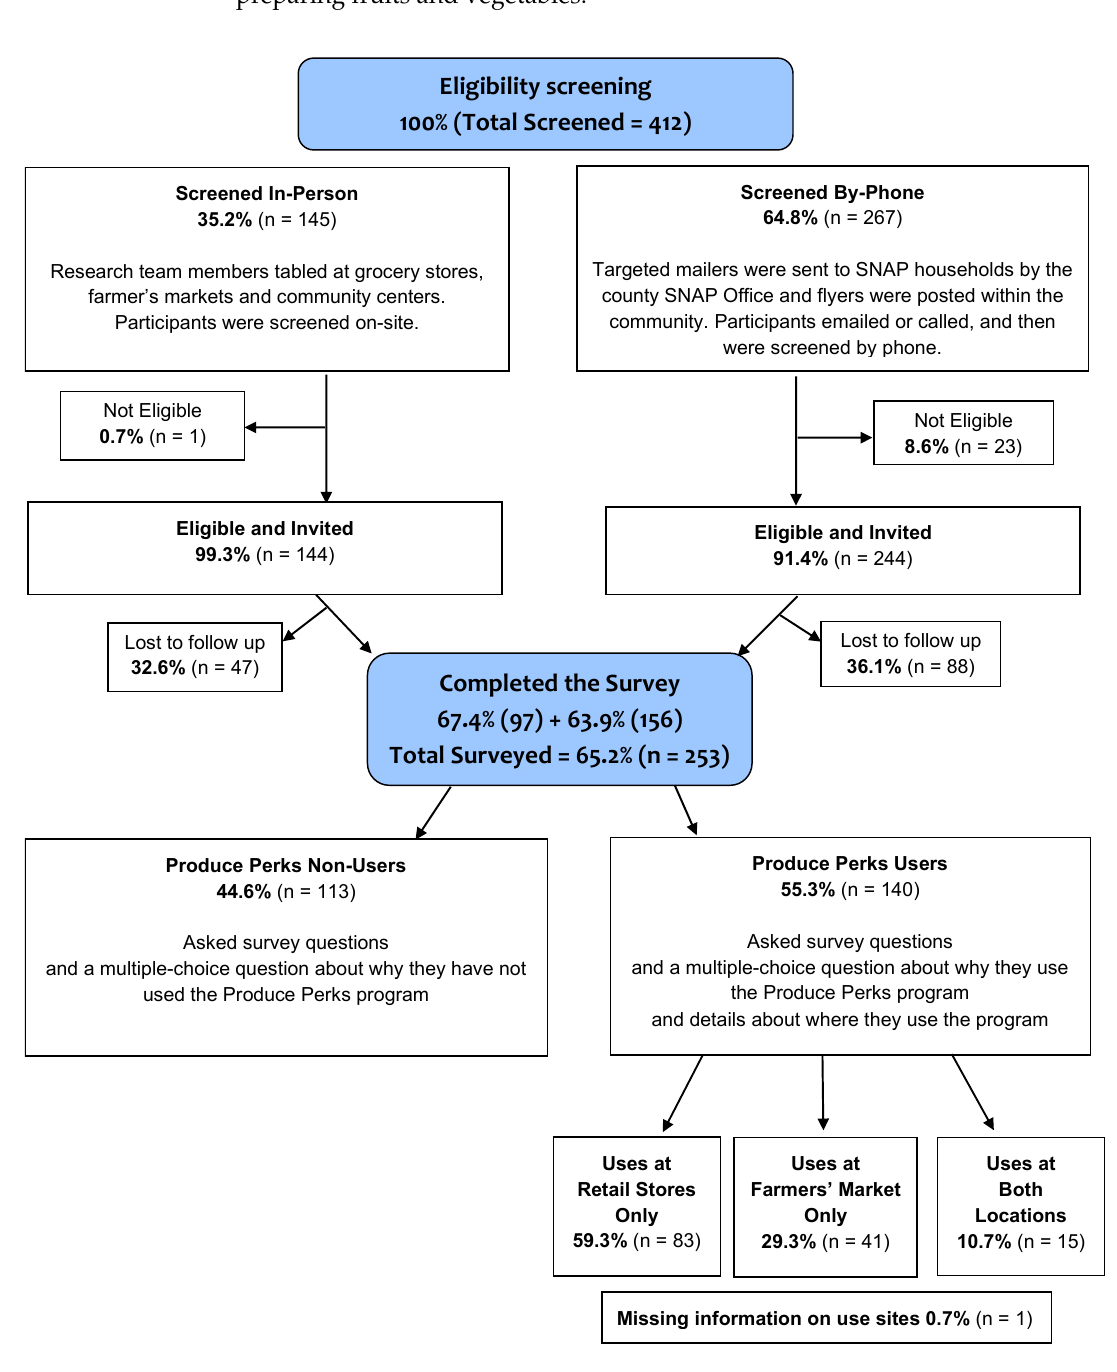
Figure 1. Study design and inclusion flow chart for the recruitment of snap consumers into a cross-sectional survey in 2019.